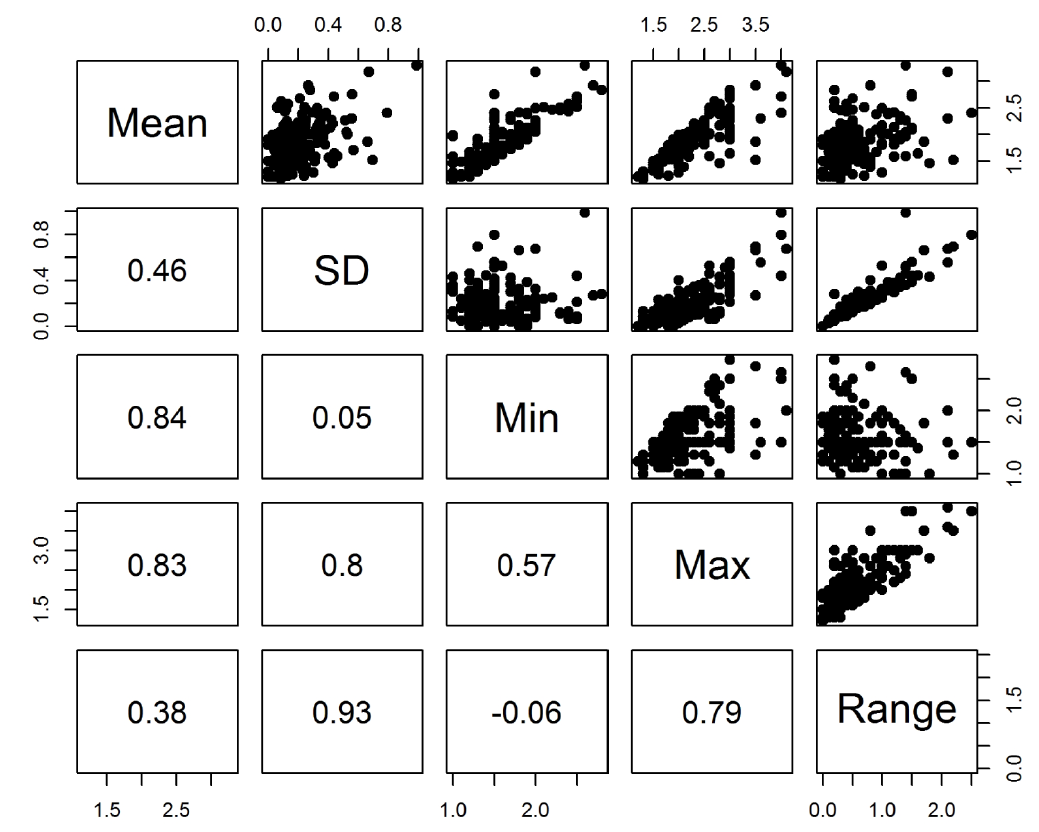
Figure 2. Scatter-plots and Pearson correlations of application score statistics. The numbers in the bottom-left diagonal of the plot matrix are the Pearson correlations.